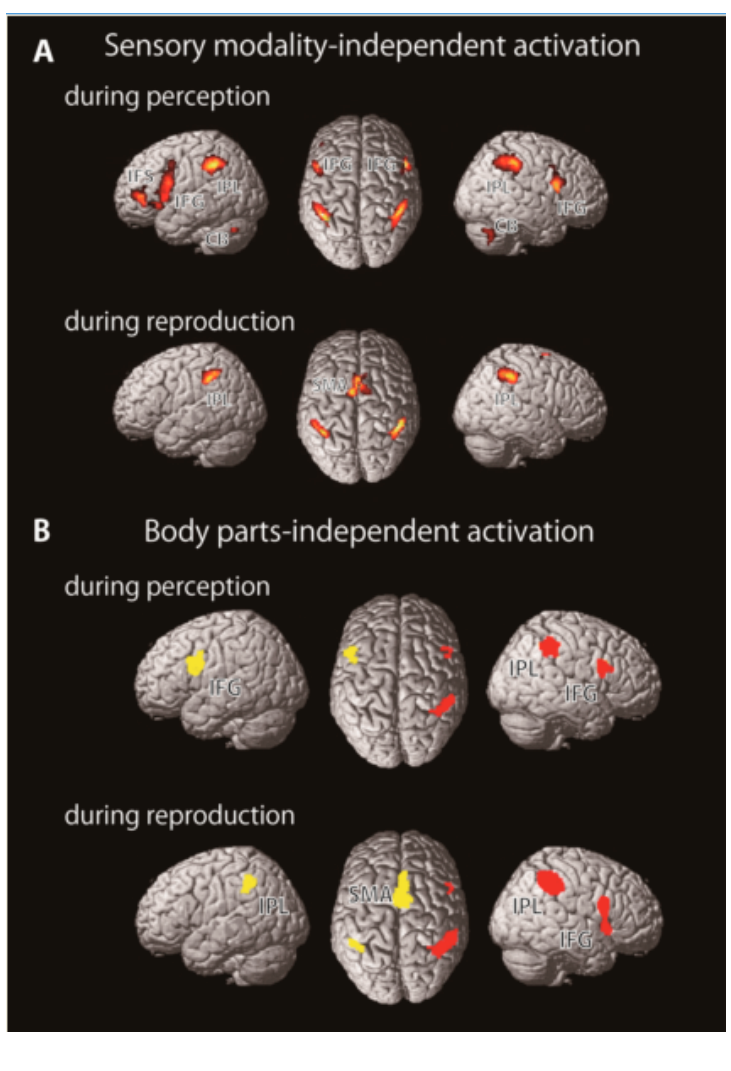
Figure 1. (A) Sensory modality-independent rhythm representation. Brain regions commonly activated during auditory and visual rhythm tasks. ( B ) Body part-independent rhythm representation. Red and yellow areas indicate the cortical regions which were activated by all three motor effectors.